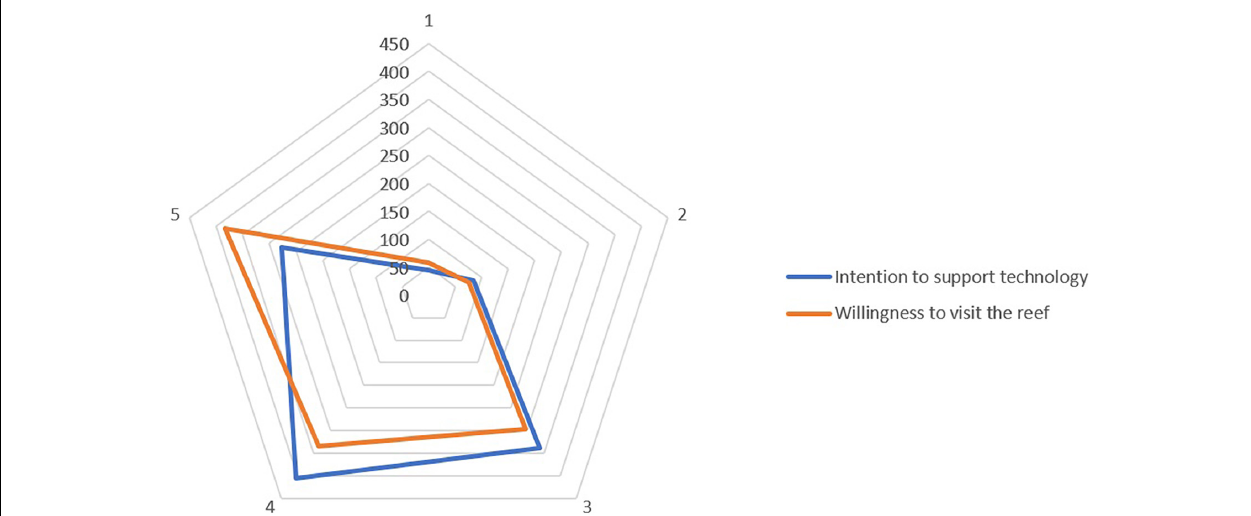
FIGURE 3 | Frequency distributions for the two dependent variables: “Intention to support development of technology” and “Willingness to visit the reef after introduction of genetically engineered coral.” Note that “technology” refers to genetically engineered coral; responses were made using a 5-point scale where higher scores indicated greater intention and willingness. TABLE 3 | Fit statistics for the hypothesized and final path models. Model Chi-square (df) Chi-square/df RMSEA Good model fit